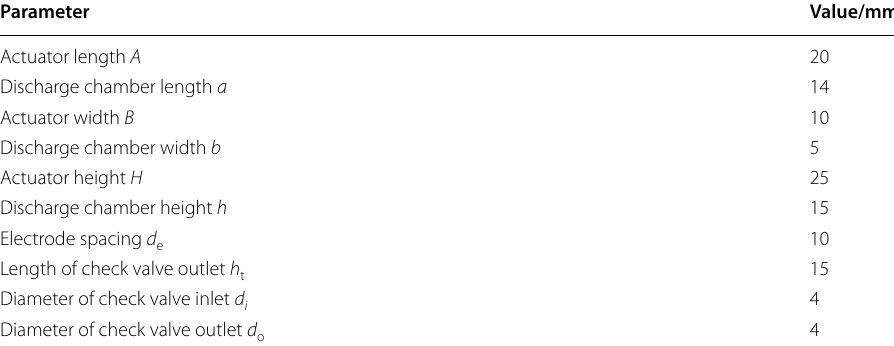
Table 1 Structural parameters of the air‑supplement PSJ actuator